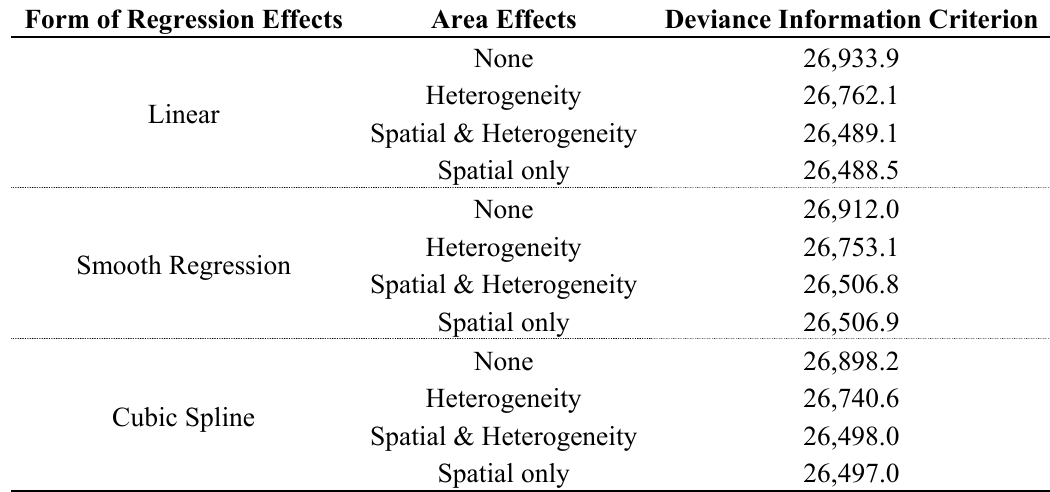
Table 1. DIC According to Regression Type and Area Effects, Suicide Deaths. Form of Regression